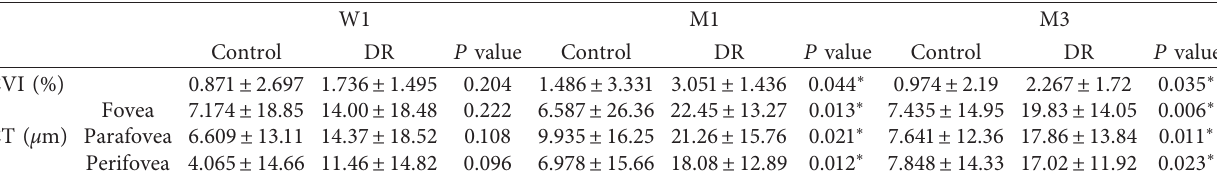
Table 3: Changes of CVI and CT after cataract surgery (mean ±